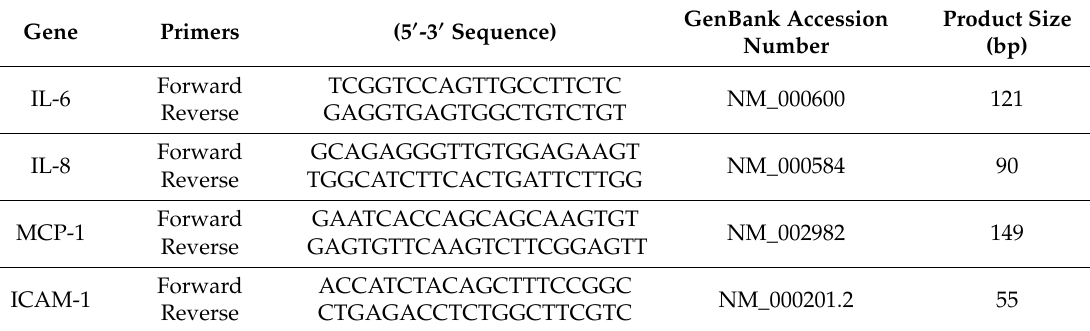
Table 1. Primers used in RT-qPCR analyses of mRNA